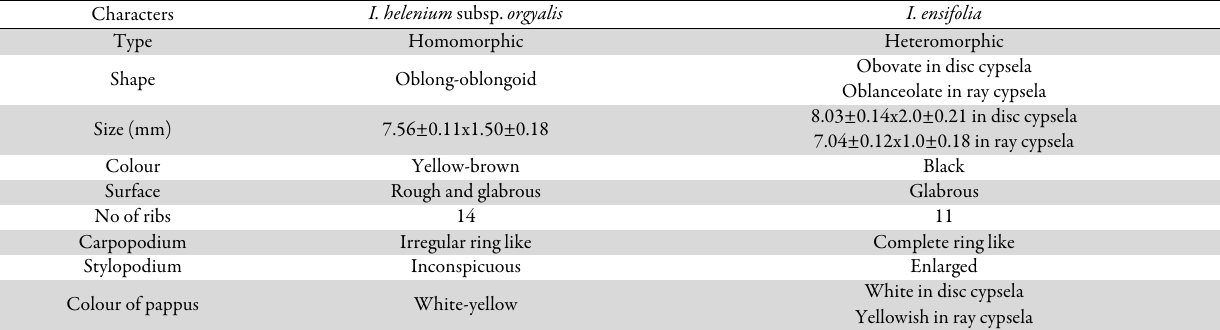
Table 3. Cypsela characters of investigated Inula L.